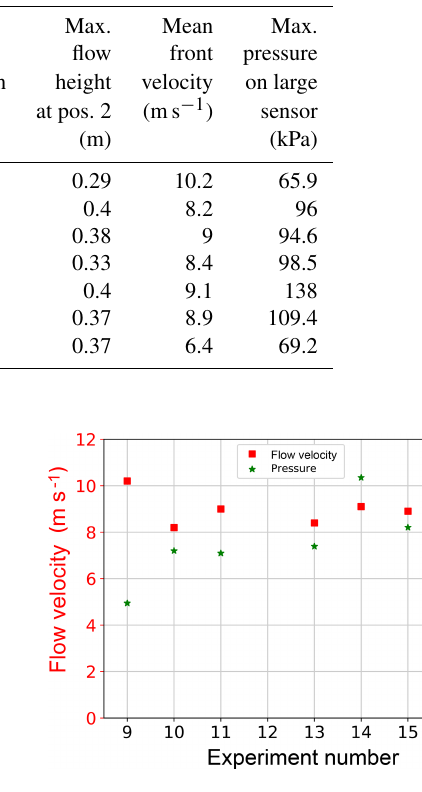
Figure 8. Measured mean flow velocity and maximum impact pres- sure for different experimental